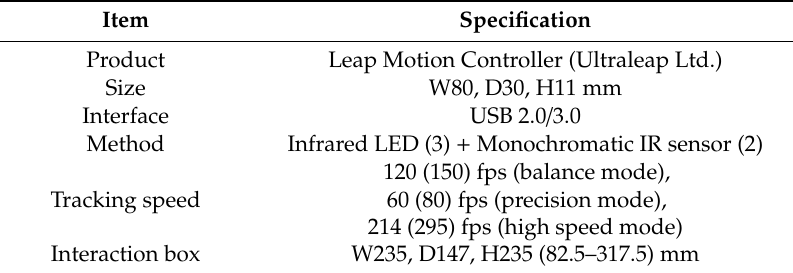
Table 4. Specifications of motion capture